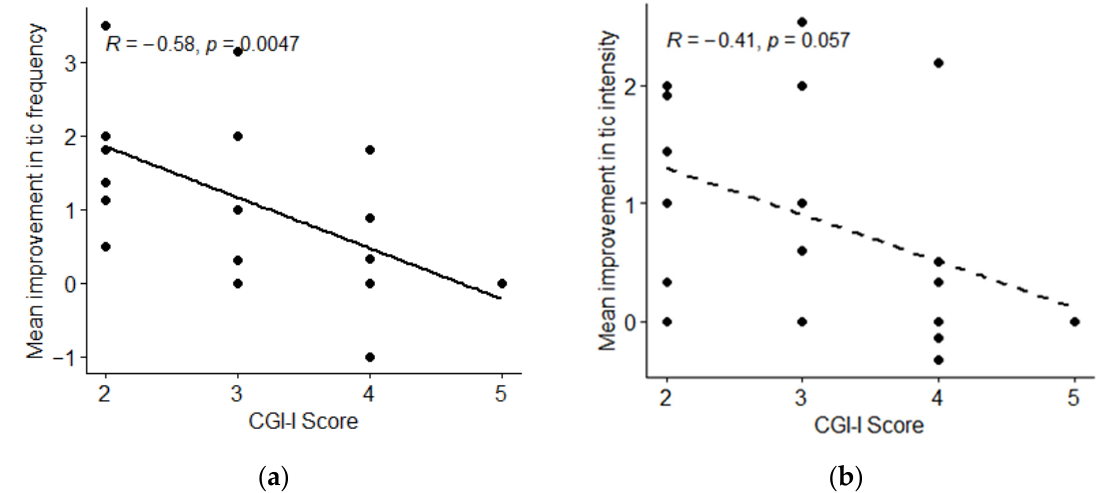
Figure 4. Correlation Between Participants’ EMA Responses During the Study and Their Report of Improvement During the Final Survey. ( a ) Mean improvement in tic frequency from EMA surveys compared with Clinical Global Impression–Improvement score for each participant (n = 22). ( b ) Mean improvement in tic intensity from EMA surveys compared with Clinical Global Impression– Improvement for each participant (n = 22).